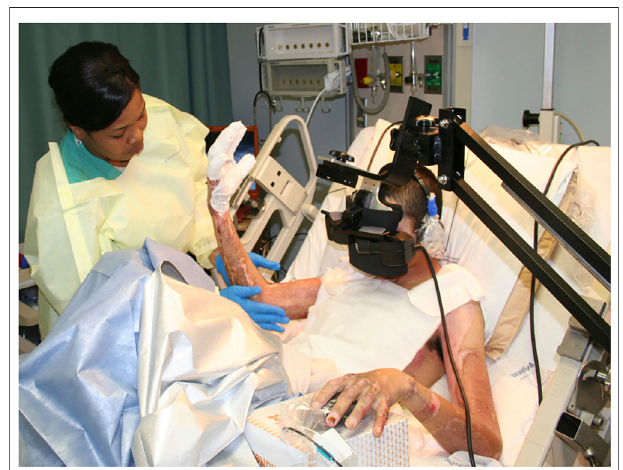
FIGURE 5 | A soldier with a combat-related burn injury during burn wound debridement while in VR. A custom robot-like arm goggle holder suspendedtheVRgogglesnearthepatientsface,sohedidnothavetoweara VR helmet on his head, which had burns. Image and copyright Hunter Hoffman, www.vrpain.com.